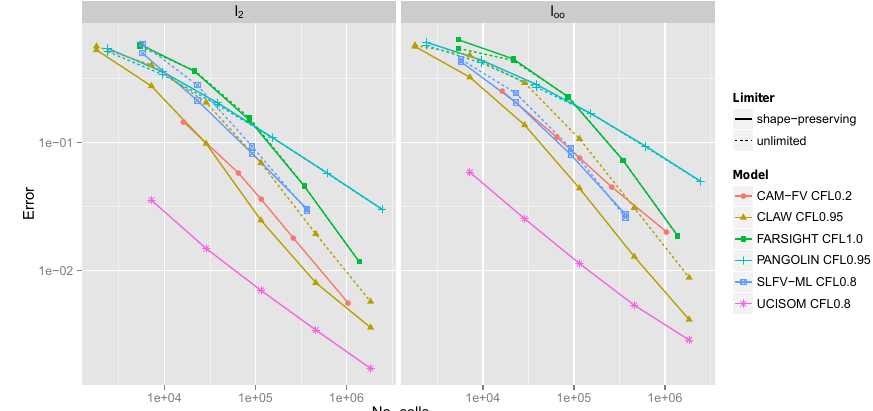
Figure 8. Numerical order of convergence for both error measures. These are computed using Gaussian hills after a full rotation. When available, the models are shown with and without the shape-preserving limiters.